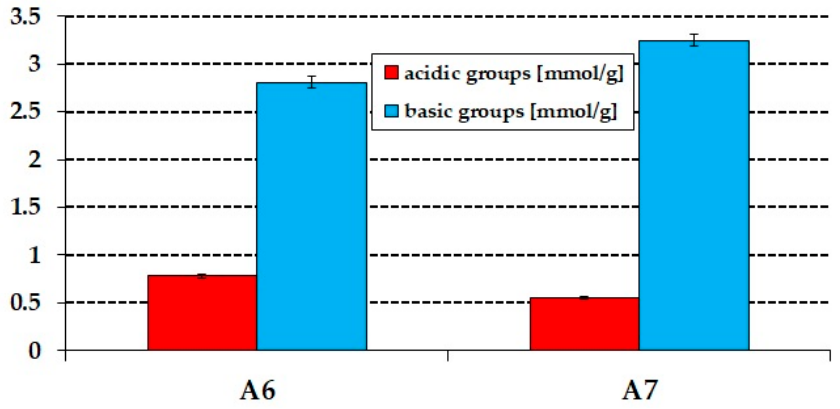
Figure 4. Acid–base properties of A6 and A7 samples obtained.